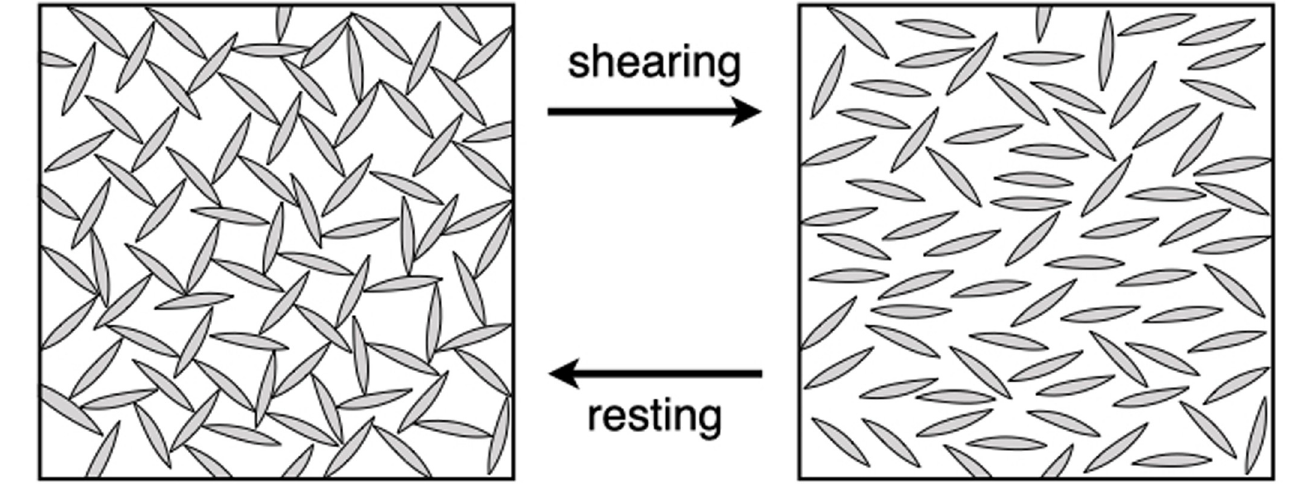
Fig 2. Breakdown of a thixotropic structure with shear stress. Modified from Barnes [27].